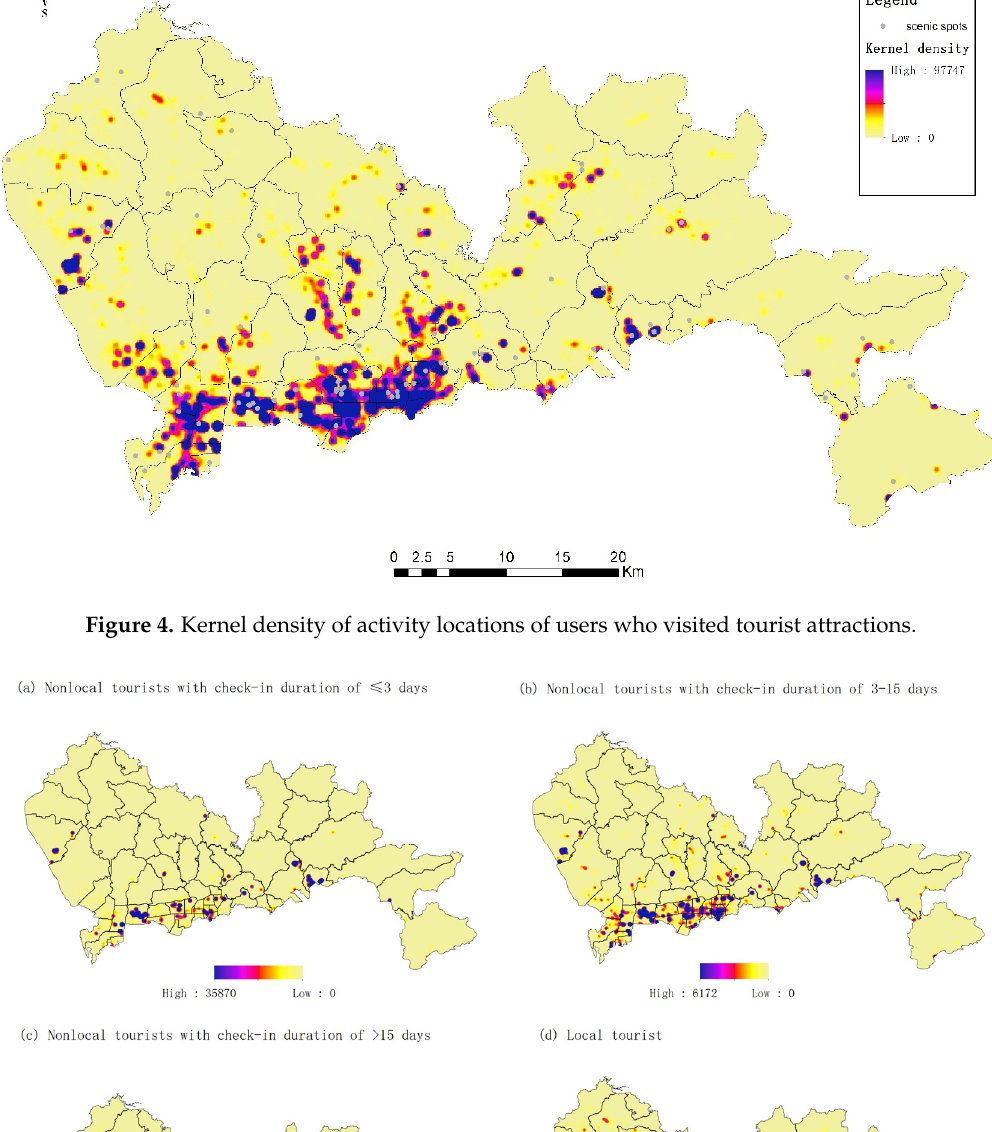
Figure 6. Matrix of check-in numbers and kernel density of 86 tourist attractions.